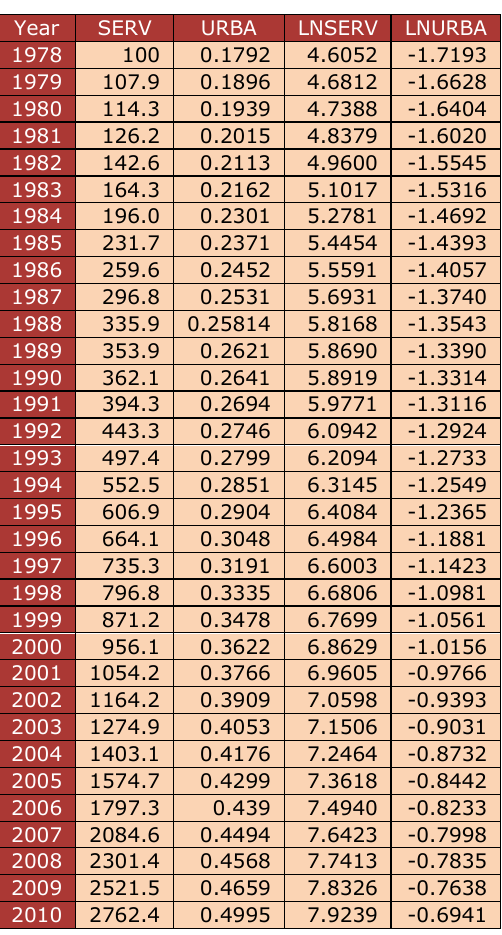
Table 1. The level of urbanization and the index number of value-added of service industry in China